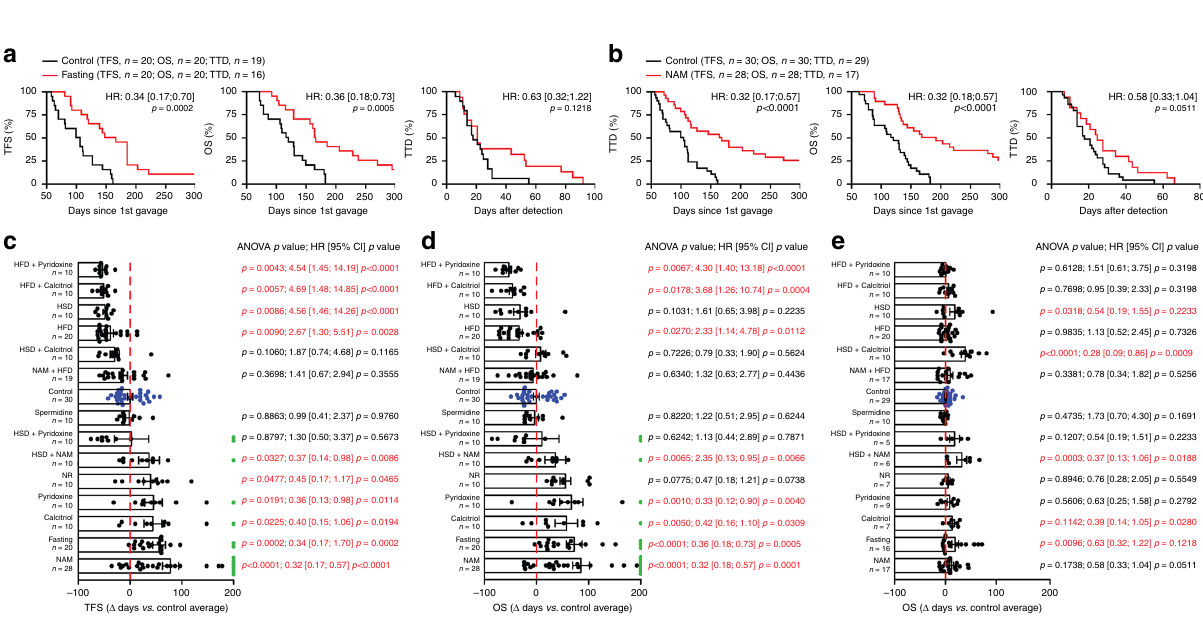
Fig. 4 Safe nutritional interventions delay M/D-driven oncogenesis. a , b Tumor-free survival (TFS), overall survival (OS) and time-to-death (TTD) of C57BL/6 mice subjected to M/D-driven oncogenesis in control conditions ( a , b ) or in the context of weekly 24-h-fasting episodes ( a ) or NAM supplementation with the drinking water ( b ). Number of mice, hazard ratio (HR) and p values (two-sided log-rank) are reported. c – e Variations in TFS ( c ), OS ( d ) and TTD ( e ) imposed to M/D-driven oncogenesis in C57BL/6 mice by the indicated nutritional interventions. Results are means ± SEM plus individual data points. Number of mice, HR and p values (two-sided log-rank and one way-ANOVA plus Fisher LSD, calculated with respect to individual control experiments) are reported. Green dots indicate mice that were free of disease ( c ) and alive ( d ) at the end of the experiment. HFD high-fat diet, HSD high sucrose diet, NR nicotinamide